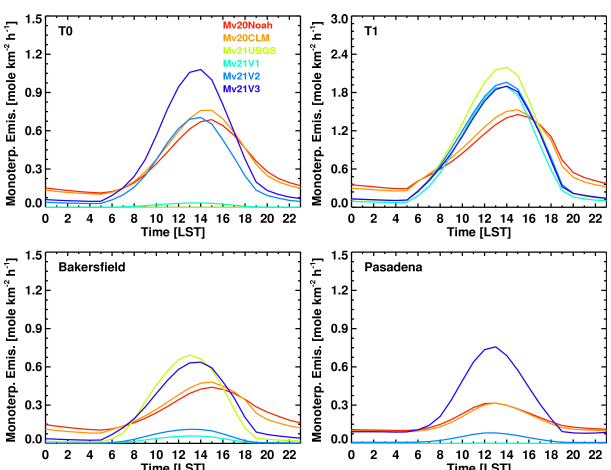
Figure 11. Same as Fig. 10, except for biogenic monoterpene emis- sions.